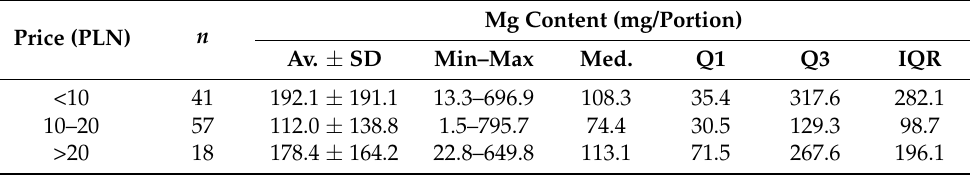
Table 5. Magnesium content in food supplements depending on the